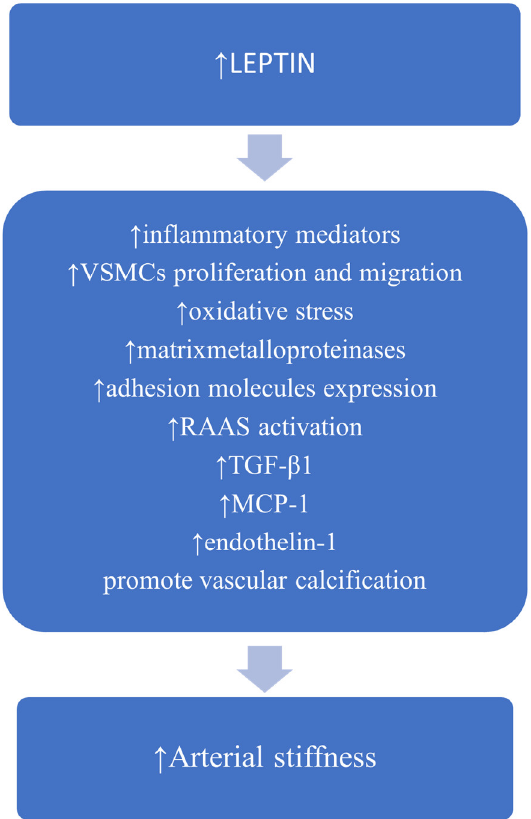
Figure 3. Possible mechanisms linking leptin to increased arterial stiffness (information based on cited articles). Abbreviations: VSMC, vascular smooth muscle cell; RAAS, renin–angiotensin–aldosterone system; TGF-β1, transforming growth factor- β1; MCP-1, monocyte chemoattractant protein-1.